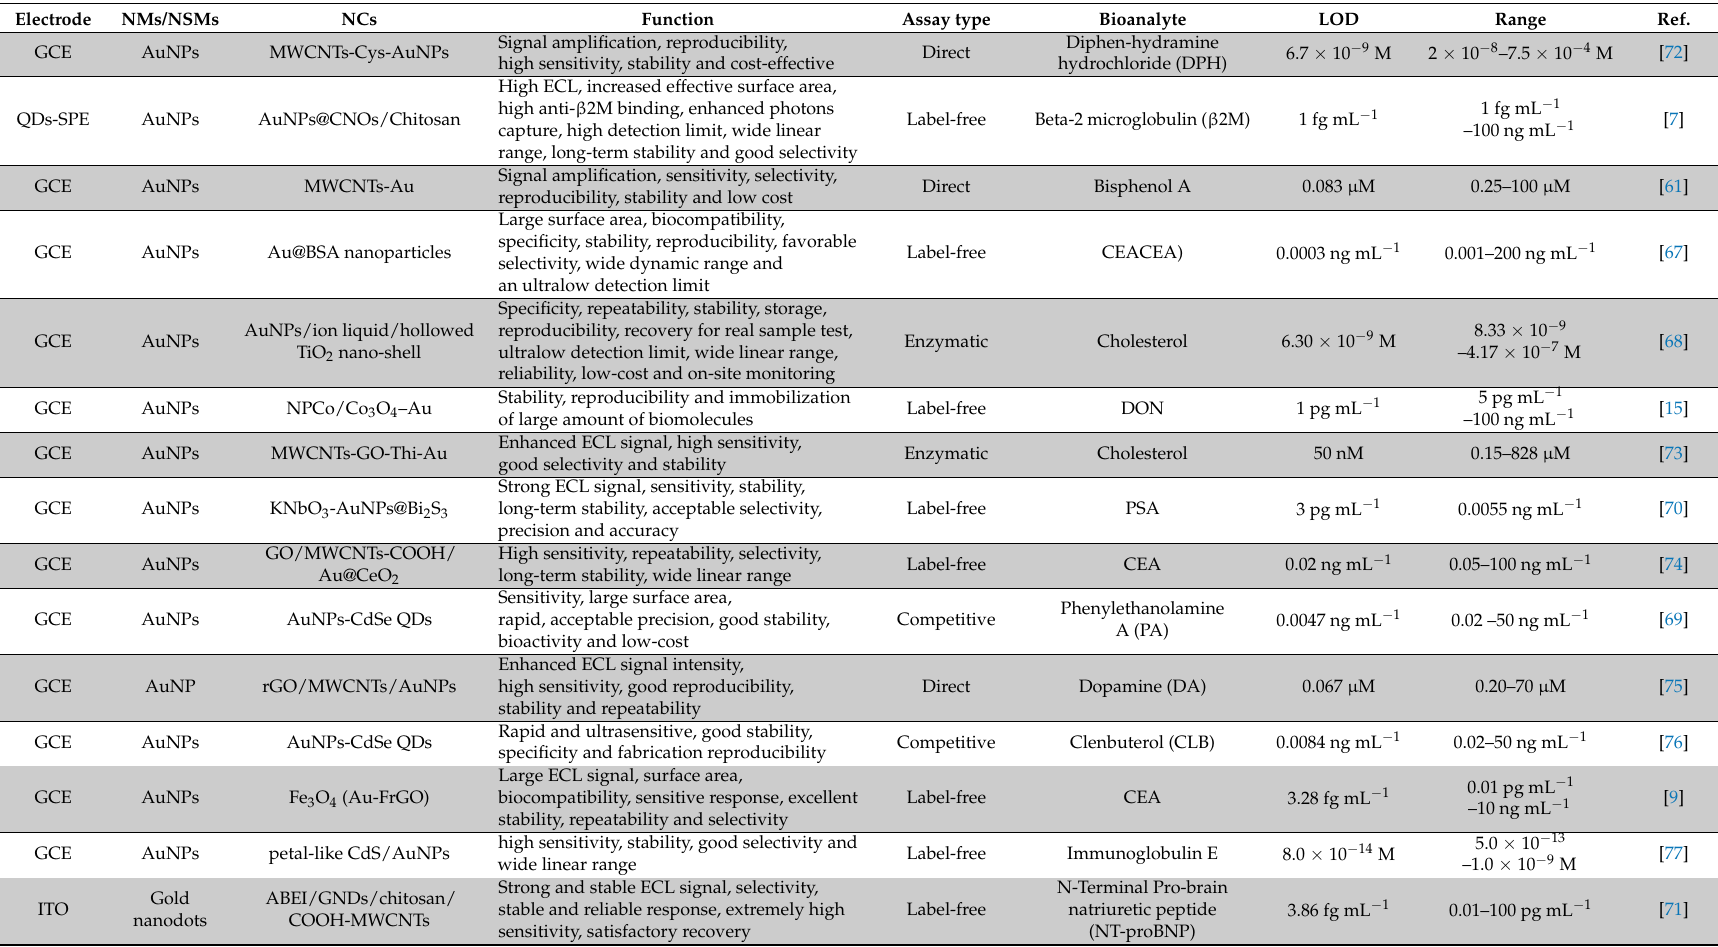
Table 2. Metals- and magnetic-NMs- or NSMs- or MNCs- or NCs-based ECL